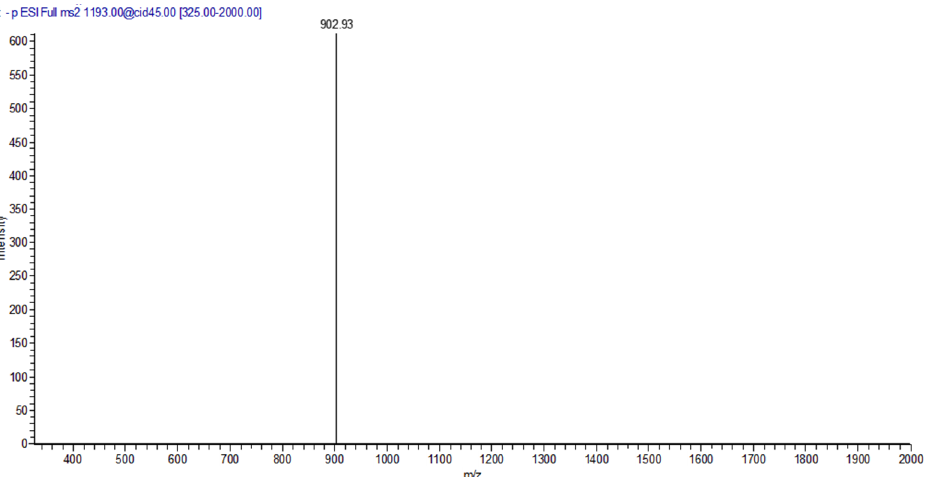
Figure 2. MS 2 spectrum of Corklin ( m / z 1193) obtained by LC MS analysis of Vintage Port wine stored in the horizontal position, with the main fragment at m / z 903 (M - 290, loss of a catechin unit).